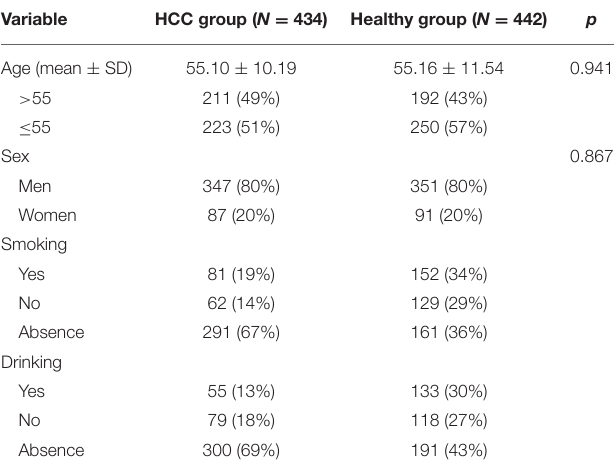
TABLE 1 | Characteristics of hepatocellular carcinoma patients and healthy subjects.